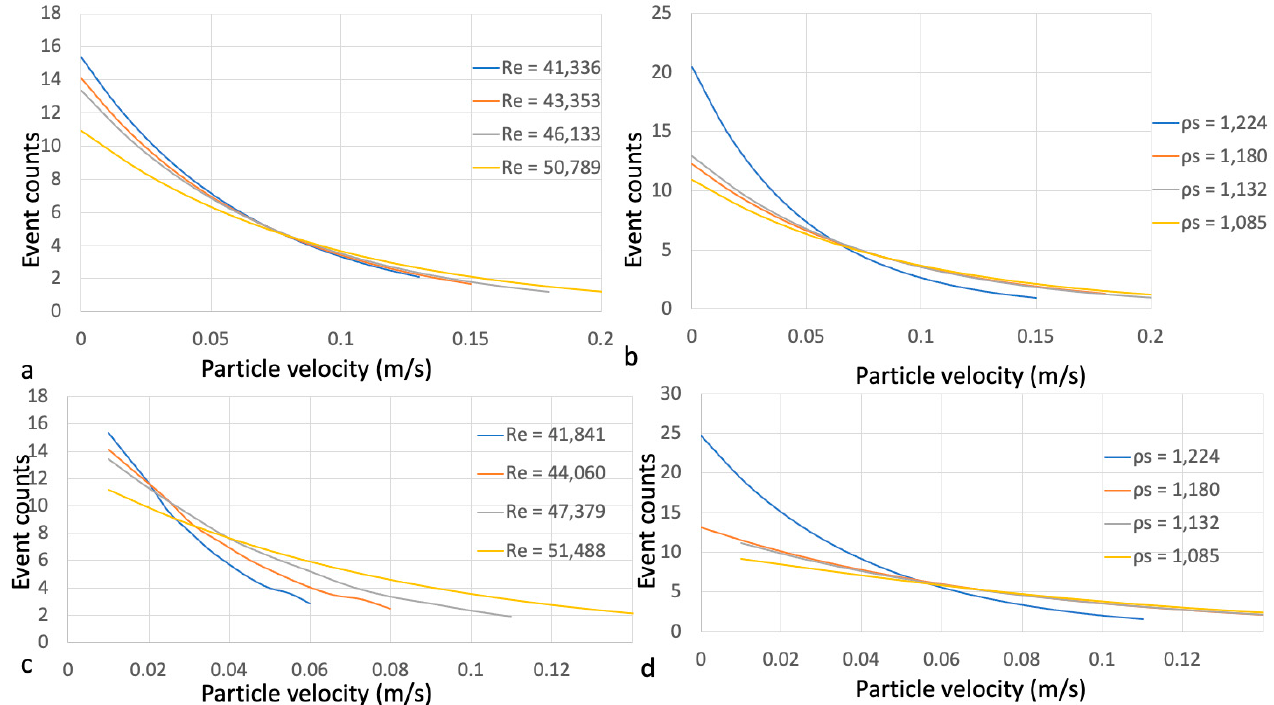
Figure 15. Instrumented particle velocity modelled by the exponential distribution: ( a ) for different flow Reynolds numbers, bed surface A and fixed instrumented particle density of 1132 kg/m 3 , ( b ) for different instrumented particle densities, bed surface A and fixed Reynolds number of 50,789, ( c ) for different flow Reynolds numbers, bed surface B and fixed instrumented particle density of 1132 kg/m 3 , and ( d ) for different instrumented particle densities, bed surface B and fixed Reynolds number of 51,488.